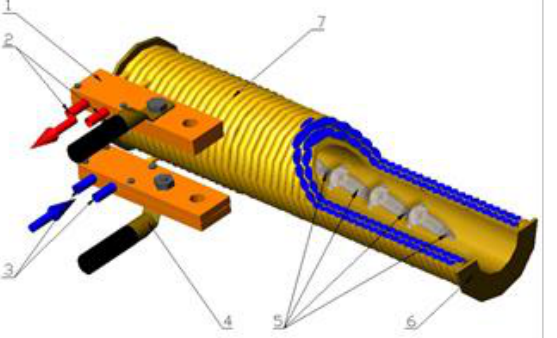
Figure 4. Diagram of the solenoid for magnetic stimulation of black garlic samples: 1 — supply chamber; 2—cooling water outlet; 3—cooling water inlet; 4—power cables; 5—sample containers; chamber; 2 — cooling water outlet; 3 — cooling water inlet; 4 — power cables; 5 — sample contain- 6—carcass; ers ; 6 — carcass; 7 — coil.